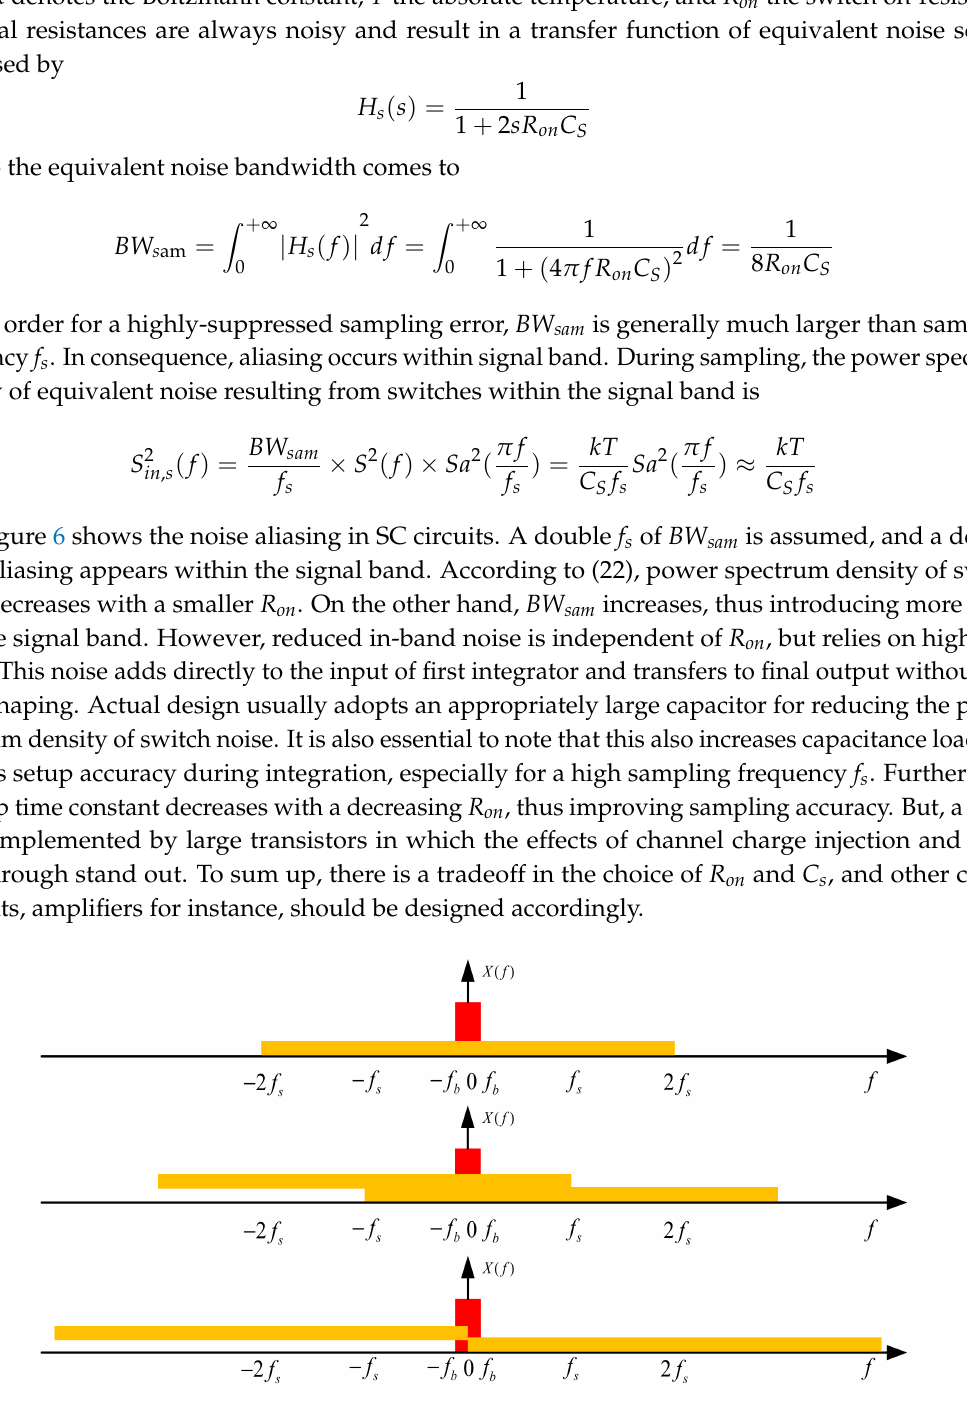
Figure 6. Simplified schematic of noise